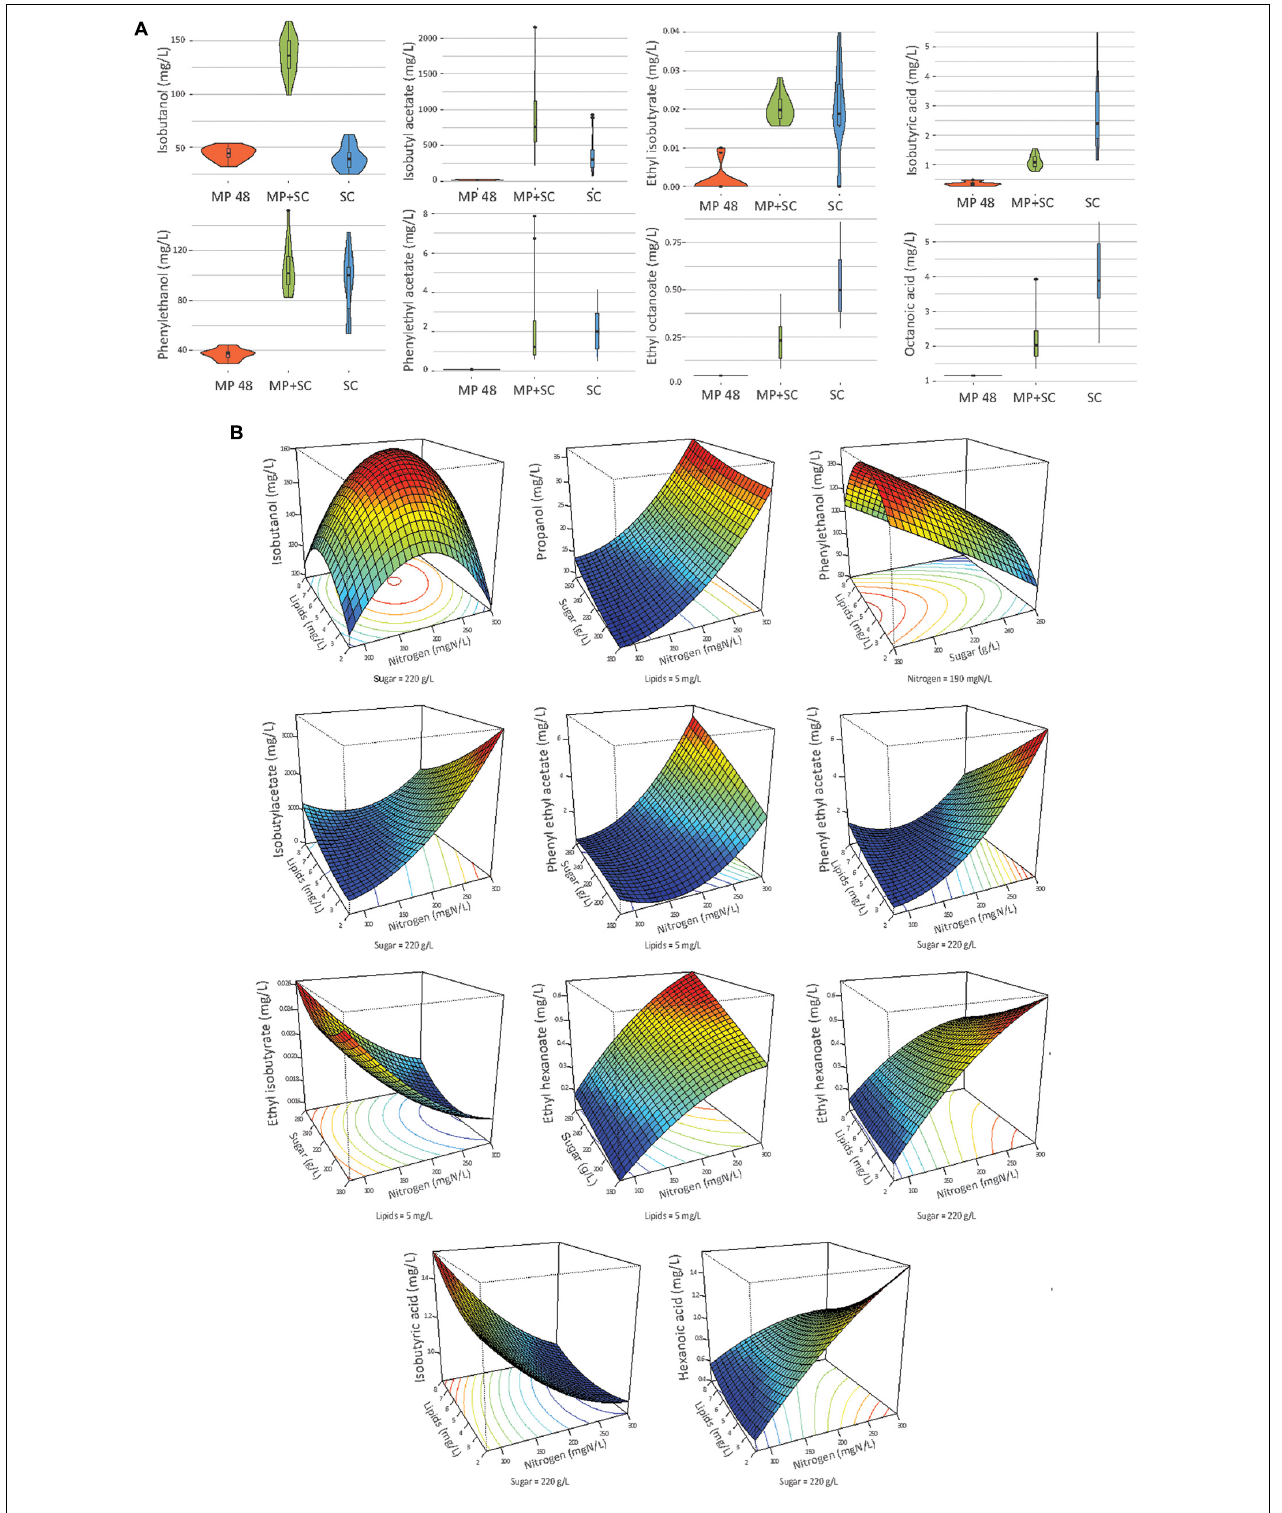
FIGURE 4 | (A) Combined violin and box plot representation of some aroma compounds produced by M. pulcherrima in pure culture after 48 h of fermentation (MP), M. pulcherrima and S. cerevisiae under sequential inoculation after 90% of fermentation progress (MP + SC) and S. cerevisiae in pure culture after 90% of fermentation progress (SC). (B) Response surfaces of fermentative aromas in relation to the variation of sugar, lipids and nitrogen under sequential inoculation. For all graphs, one parameter is fixed.